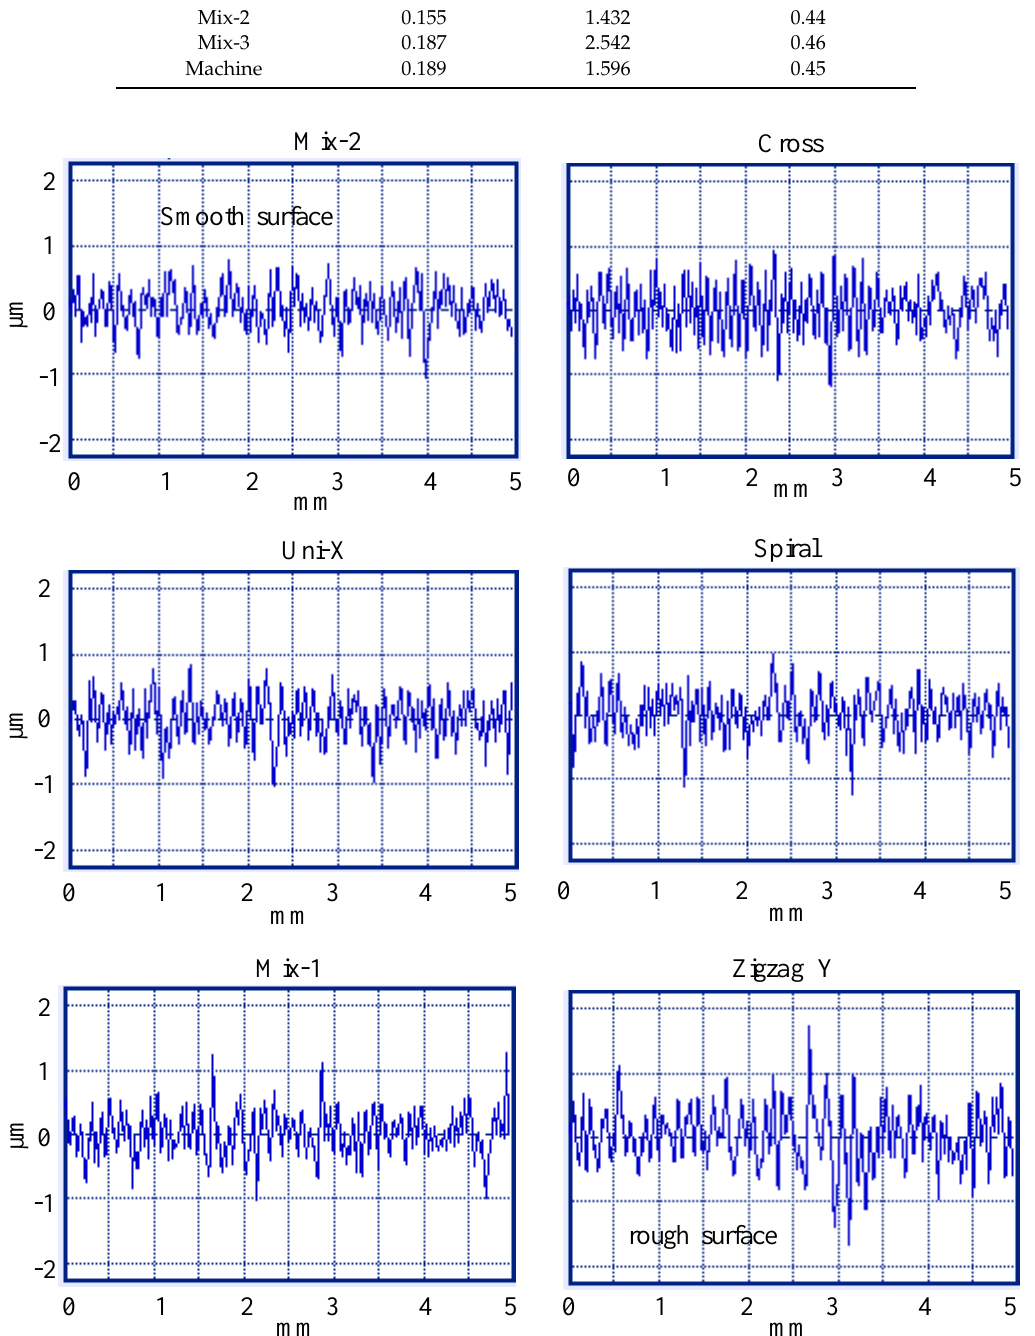
Figure 11. 2D surface roughness profiles of the machined pockets.